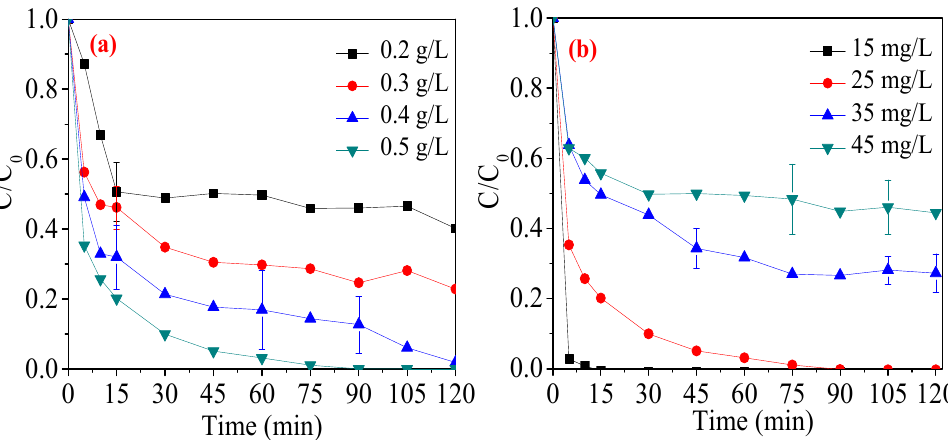
Figure 5. Removal of Cr(VI) by nZVI at different ( a ) nZVI dosage and ( b ) initial Cr(VI) concentration. Here, ( a ) [nZVI] = 0.5 g/L, pH = 3, T = 293 K; ( b ) [Cr(VI)] = 25 mg/L, pH = 3, T = 293 K.